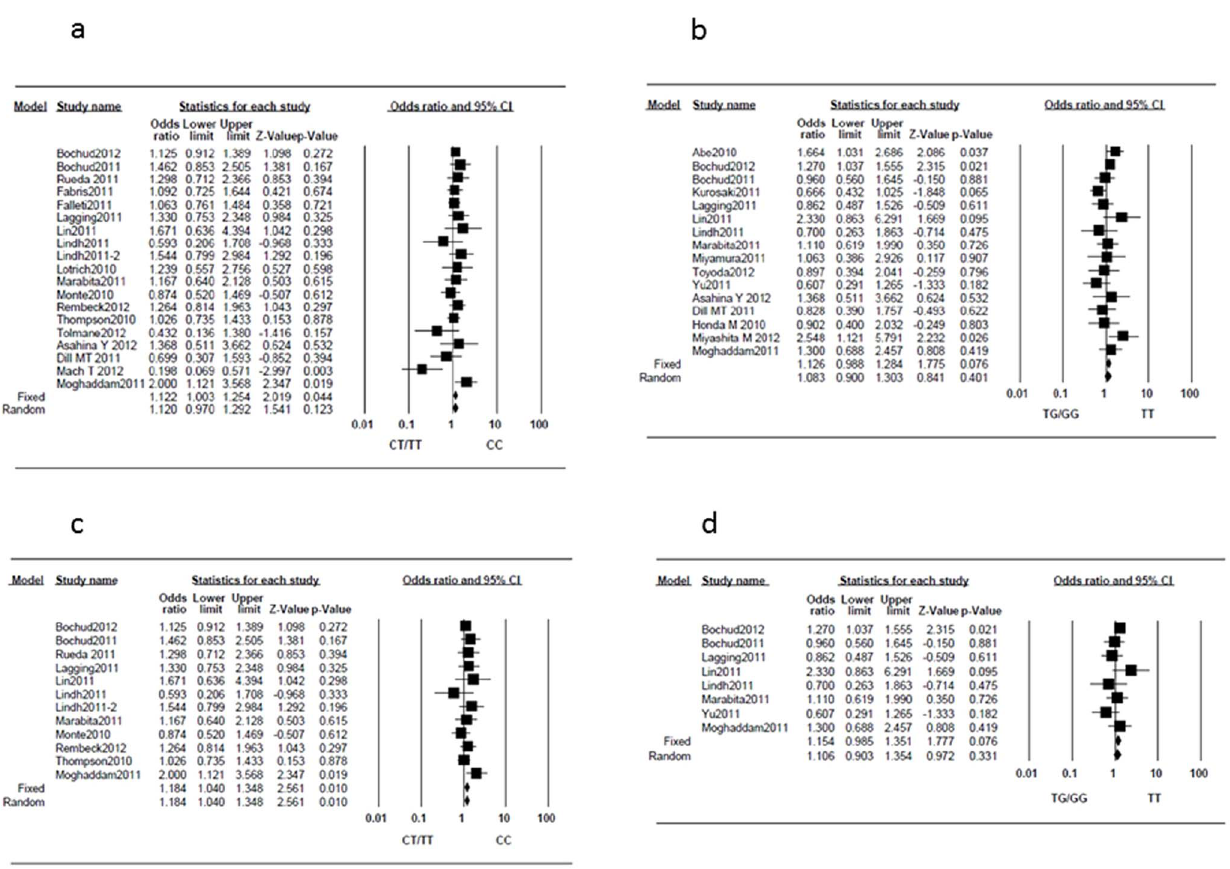
Figure 2. Forest plot of the IL28B genotypes and the risk of severe fibrosis. (a) rs12979860 in all patients, (b) rs8099917 in all patients, (c) rs12979860 in treatment-naı¨ve patients, and (d) rs8099917 in treatment-naı¨ve